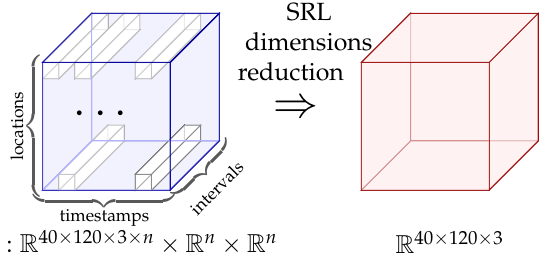
Figure 3. State representation learning (SRL) dimensionality reduction.